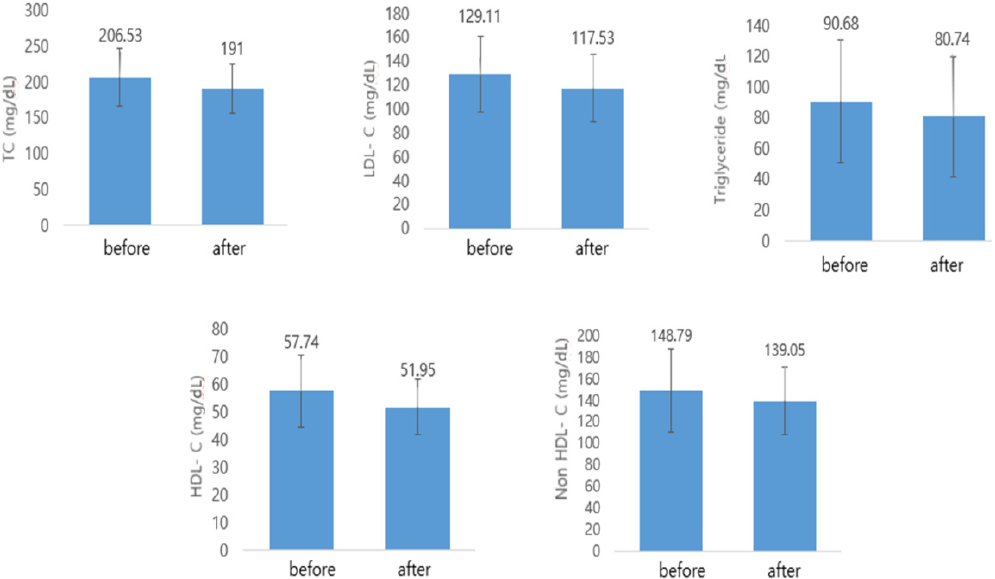
Figure 3. Lipid profile before and after Kochujang treatment in the HTK group. HTK, traditional Kochujang containing a high dose of beneficial microbes. TC, total cholesterol; LDL-C, low-density lipoprotein cholesterol; HDL-C, high-density lipoprotein cholesterol; NonHDL-C, non-HDL-C.